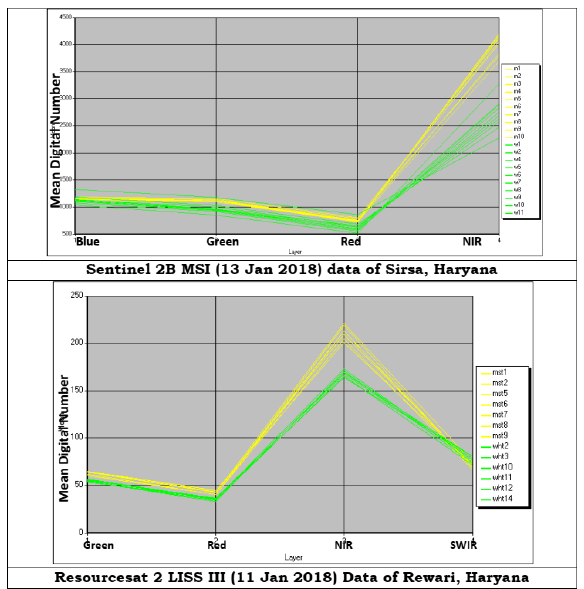
Figure 7: Mean DN values of different crops as seen in multi- spectral data (Yellow: Rapeseed & Mustard, Green: Wheat)